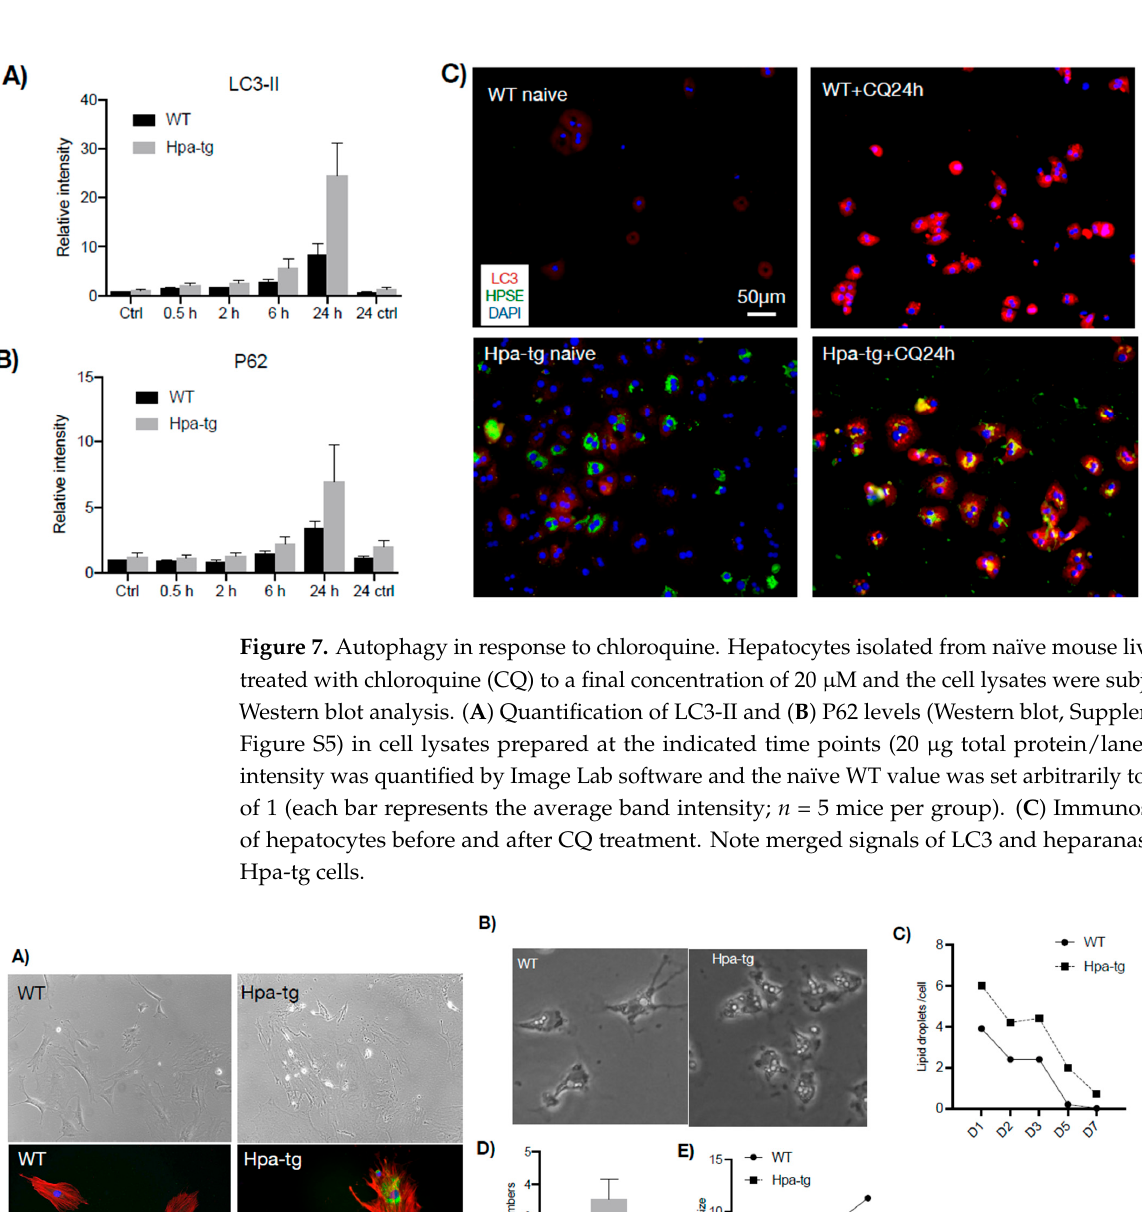
Figure 6. Autophagy. Frozen liver tissues were homogenized in RIPA buffer and total protein was